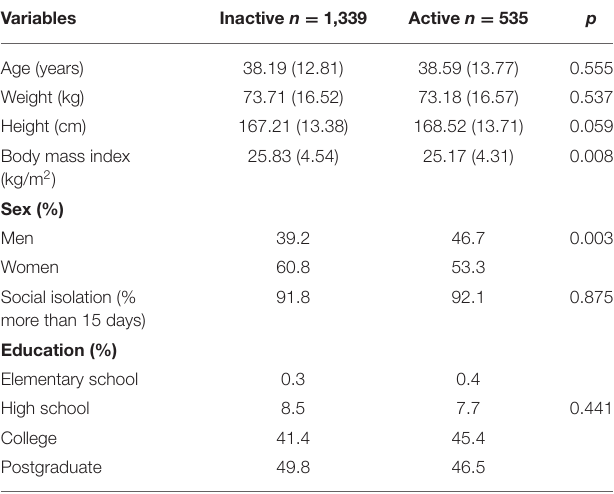
TABLE 1 | Comparison of the characteristics of physical inactive and active Brazilians who answered an online survey during the COVID-19 social isolation, n =